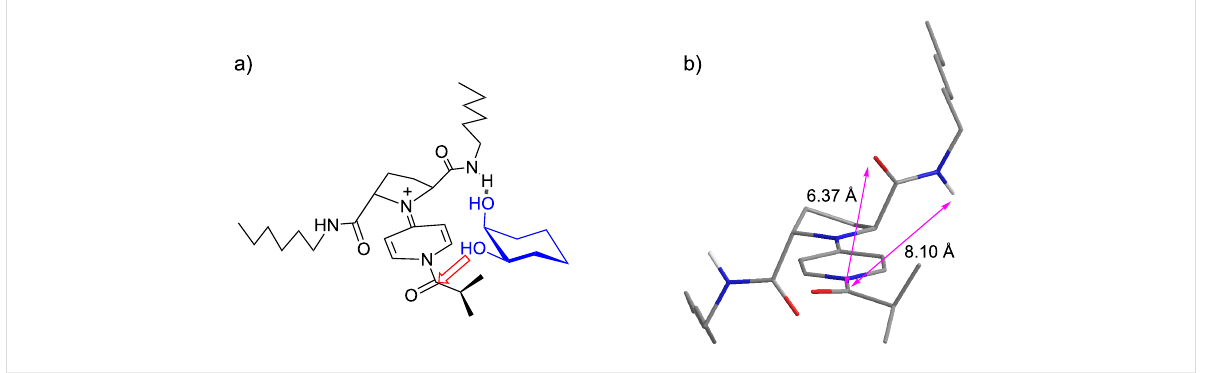
Figure 3: An alternative model for the transition state assembly of the asymmetric acylation of 5 promoted by catalyst 11 . a) A possible mode of the substrate approach to acylpyridinium ion A , and b) the calculated structure of A .